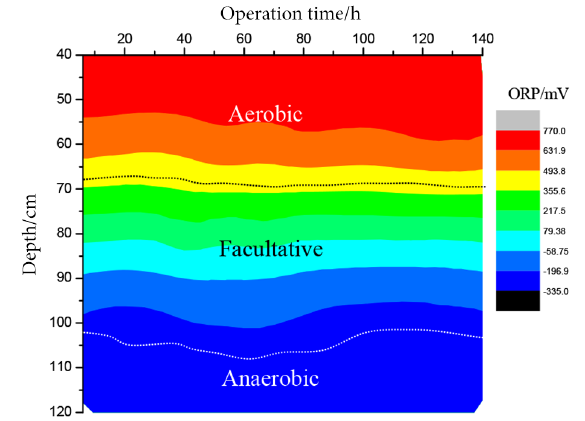
Figure 4. Evolution of ORP versus depth and operation time. ORP profiles were established from five measurements (40, 60, 80, 100 and 120 cm depth), using spatial linear interpolation